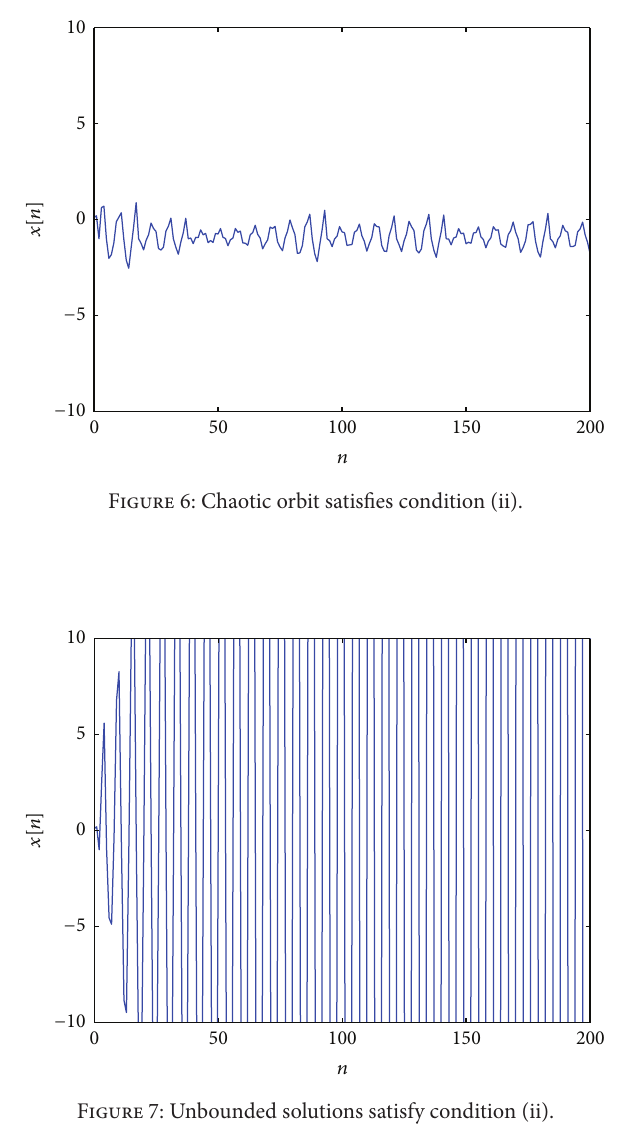
Figure 7: Unbounded solutions satisfy condition (ii).